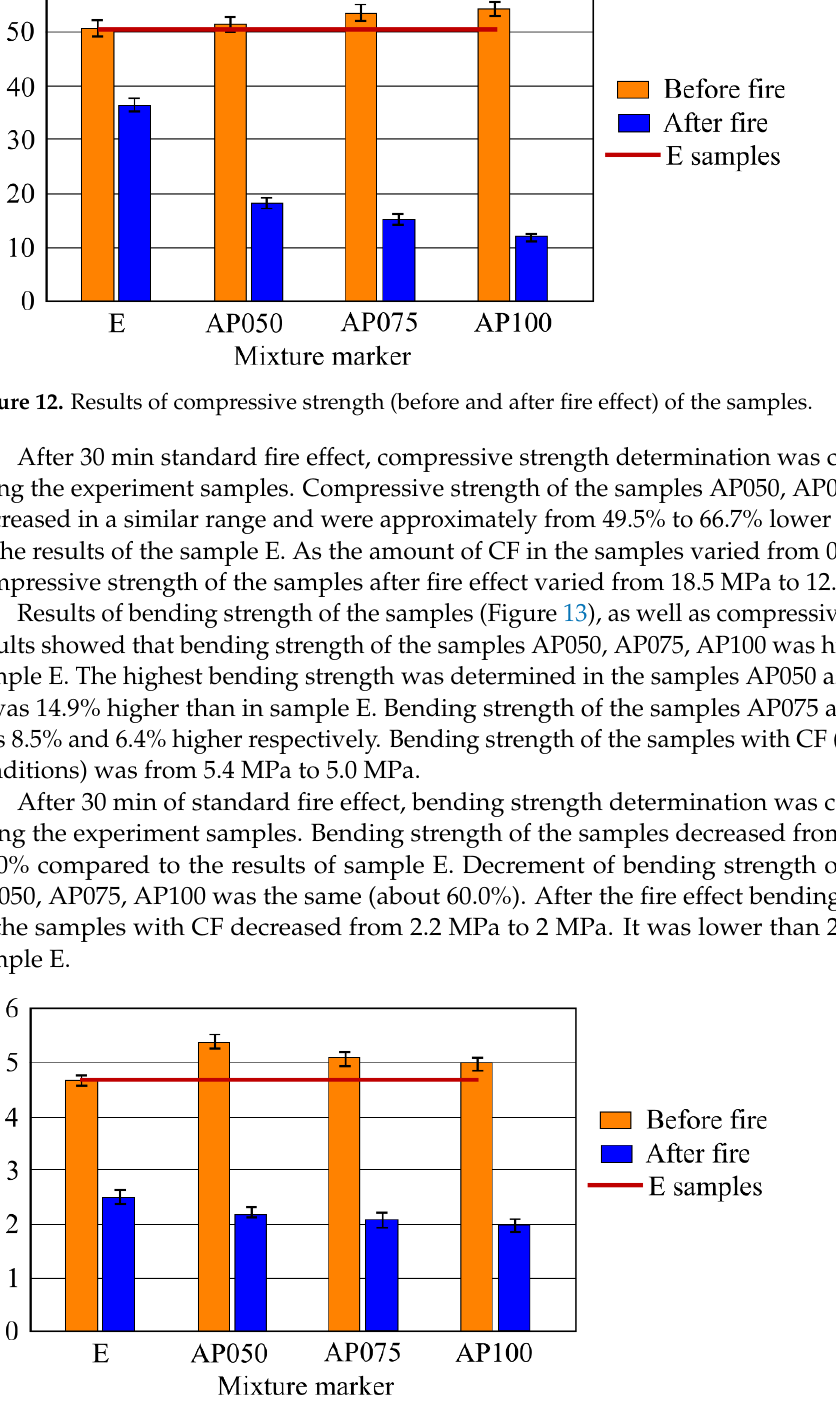
Figure 13. Results of bending strength (before and after fire effect) of the samples